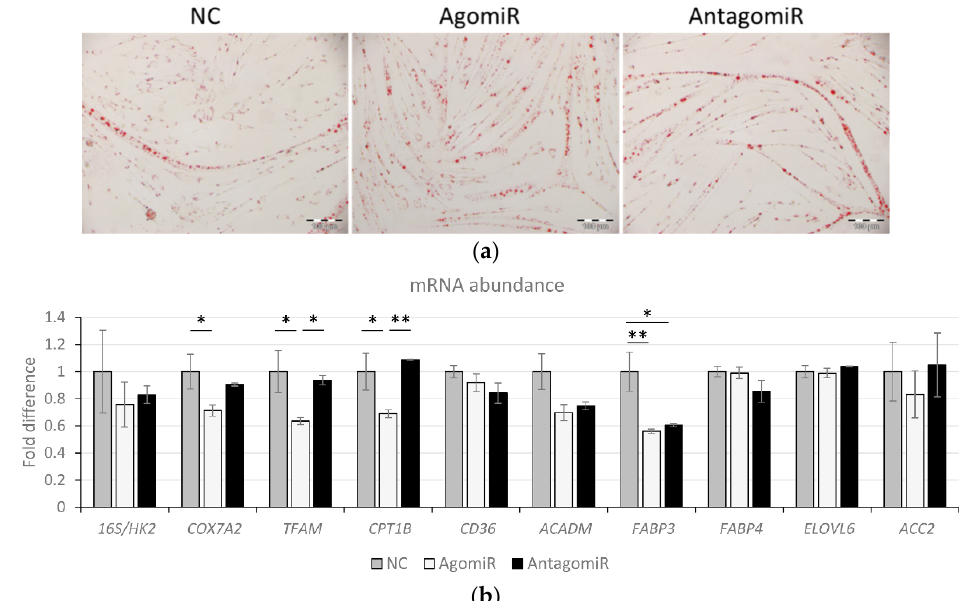
Figure 6. Impact of agomiR and antagomiR on oleic acid accumulation in bovine satellite cell myotubes. ( a ) Morphological images of Oil red O stained myotubes treated with agomiR, antagomiR, and negative control (NC) plus oleic acid (OA). Scale bars represent 100 μ m. ( b ) The qPCR results determine transcript levels of fat oxidation and metabolism related genes in myotubes treated with OA in presence of agomiR and antagomiR. Data is representative of two or three independent experimental replicates per sample group. Expression levels were normalized to GAPDH and are presented as fold differences to NC. Significant differences among treatments are indicated with * if p < 0.05 or ** if p < 0.01. Table 3. Image analysis of Oil red O stained bovine satellite cell myotubes after treatment with oleic acid and agomiR or antagomiR compared to a negative control.